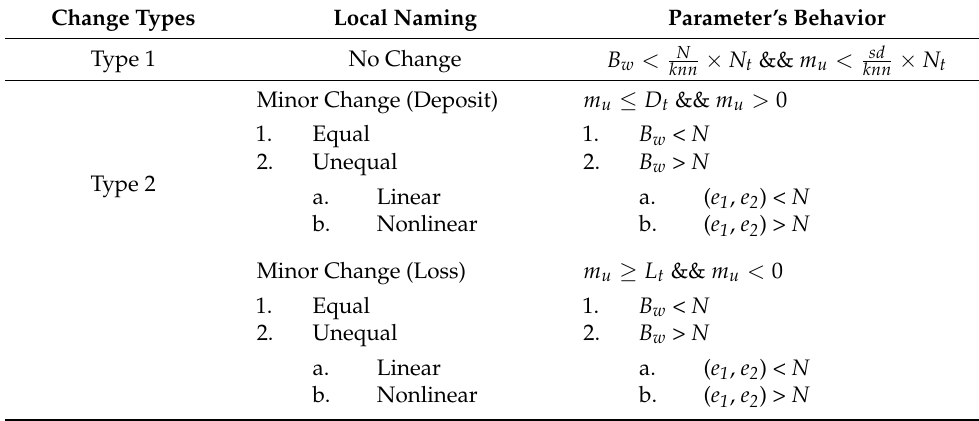
Table 3. Ground truth based on the histogram parameters.